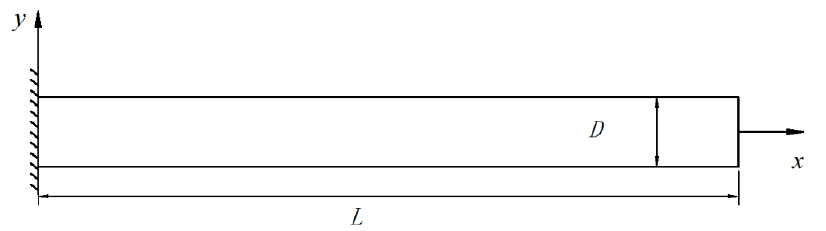
Figure 2. The geometric configuration of the cantilever beam in plane stress condition.